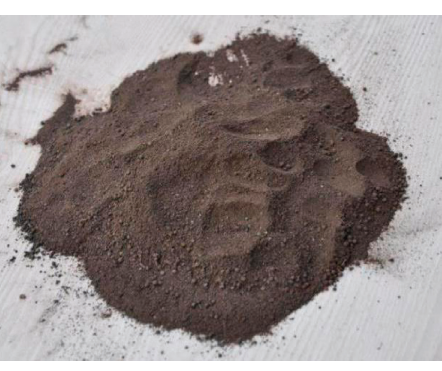
Figure 1: Research method flow chart.